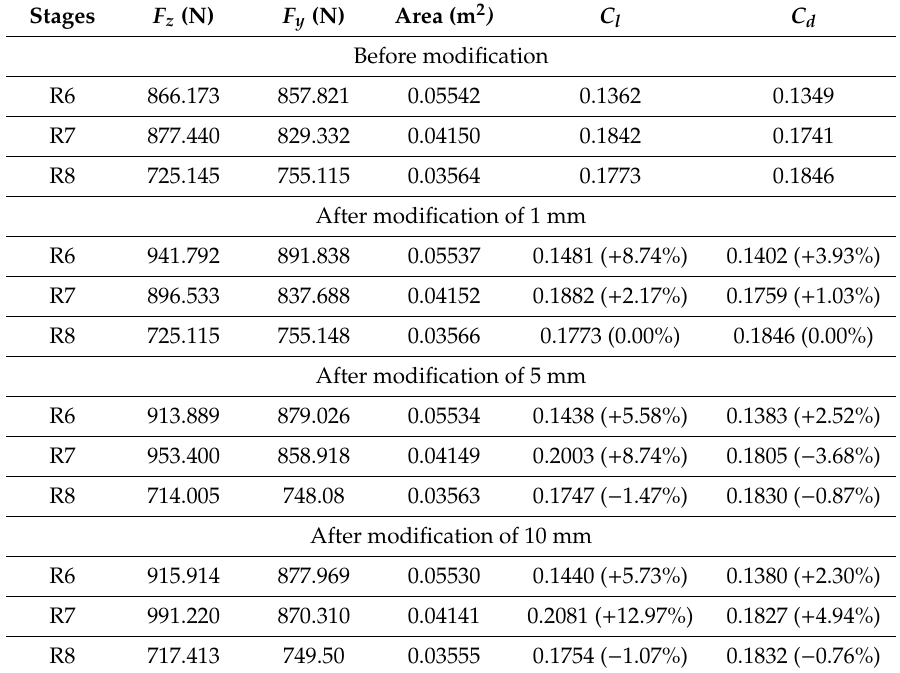
Table3. C l and C d